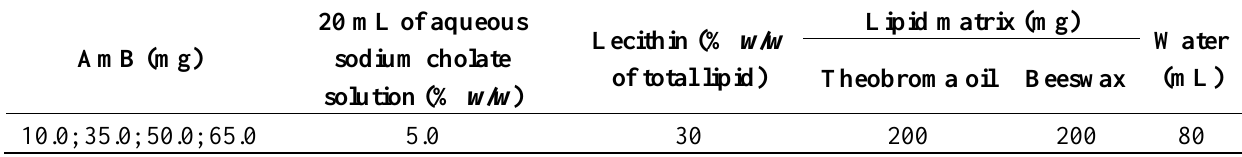
Table 1. Formula of lipid nanoparticles as a function of amount of